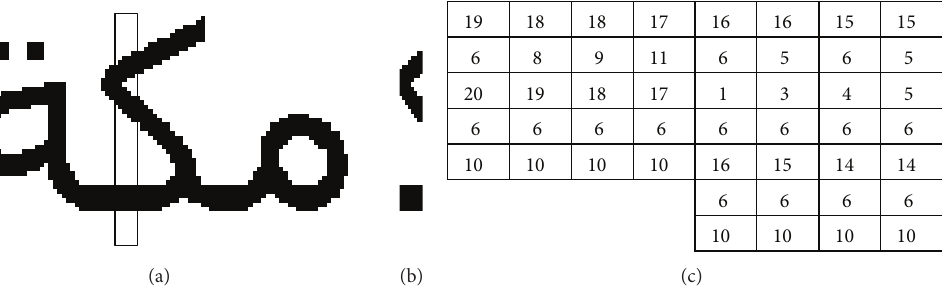
Figure 2: RLE implementation to binary image.